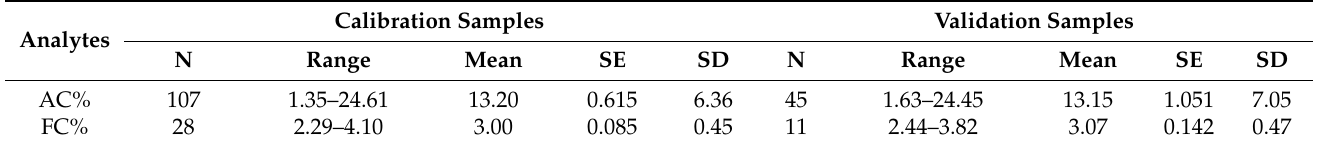
Table 1. AC and FC of samples measured using trace detection methods.